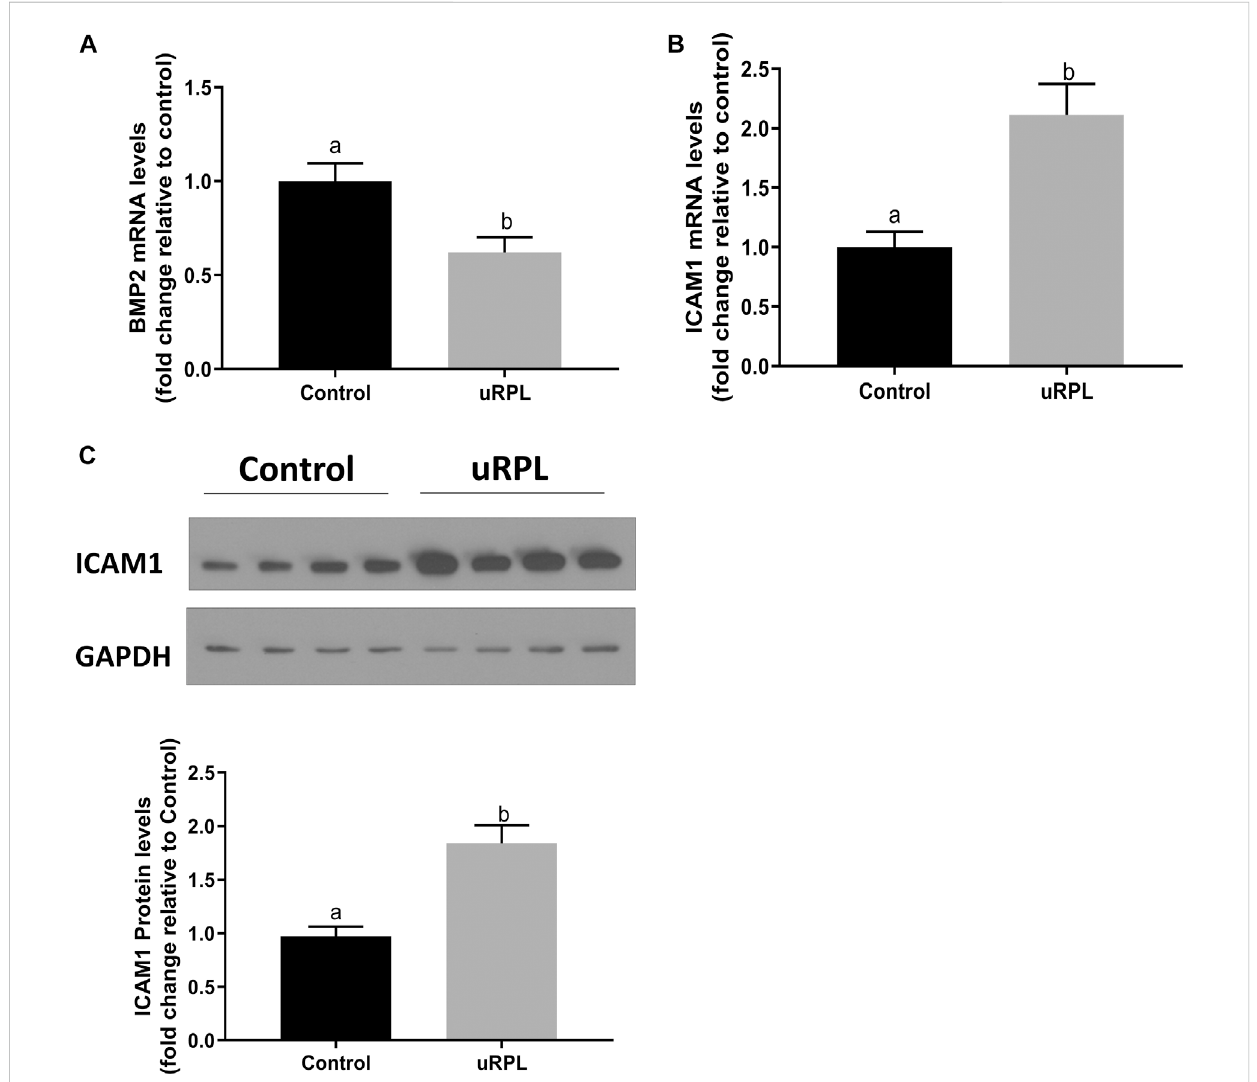
FIGURE 1 Expression levels of BMP2 and ICAM1 in the endometrium obtained from patients with unexplained recurrent pregnancy loss (uRPL) and fertile women (as a control). The endometrial samples were obtained from 12 uRPL patients and 16 fertile women (Control) during their mid-secretory phases. (A,B) The mRNA levels of BMP2 (A) and ICAM1 (B) of the endometrial tissues obtained from uRPL and controls were examined using RT-qPCR. (C) The protein levels of ICAM1 of the endometrial tissues obtained from uRPL and controls were examined using Western blot analysis. The results are expressed as the mean ± S.E.M. Different letters indicate a signi fi cant difference ( p <